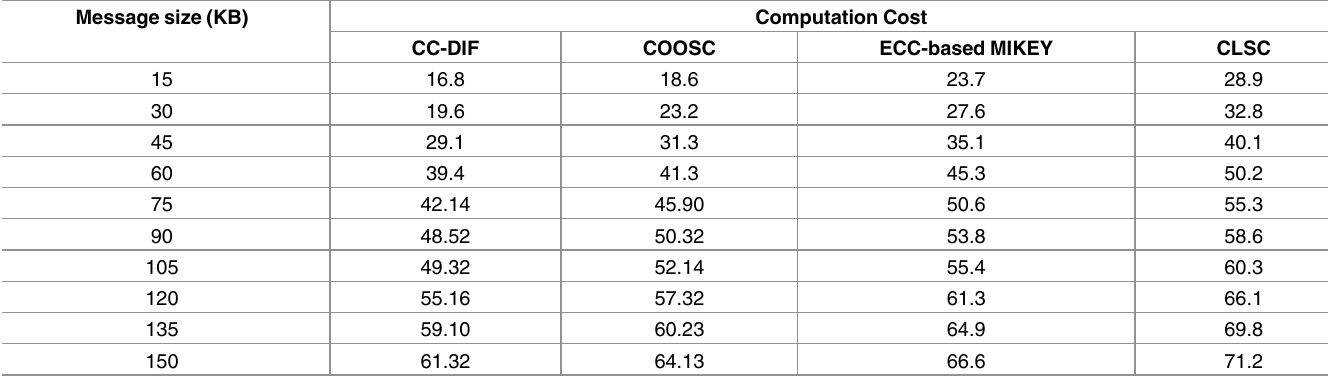
Table 2. Tabulation for computation